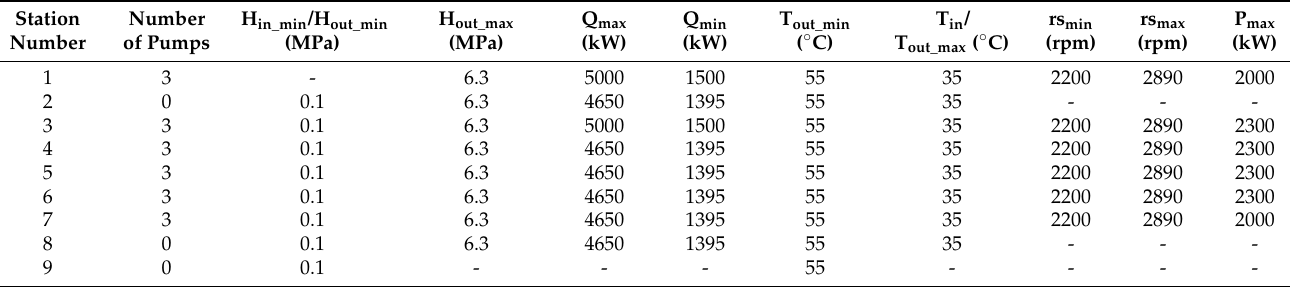
Table 3. Related parameters of oil pumps at each